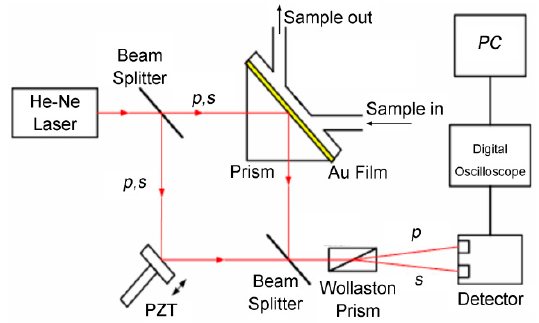
Figure 6. Temporal phase modulation interferometry scheme for SPR phase interrogation (Adapted from [60]).